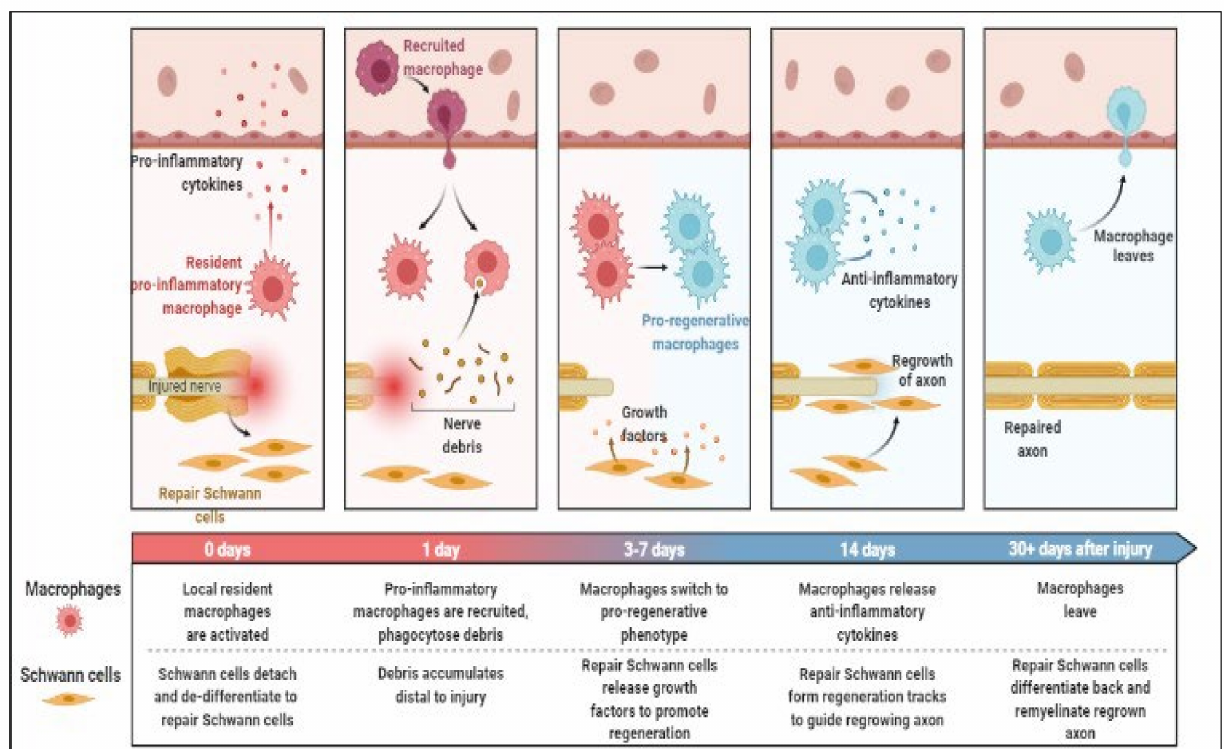
Figure 1. Inflammation and regeneration of peripheral